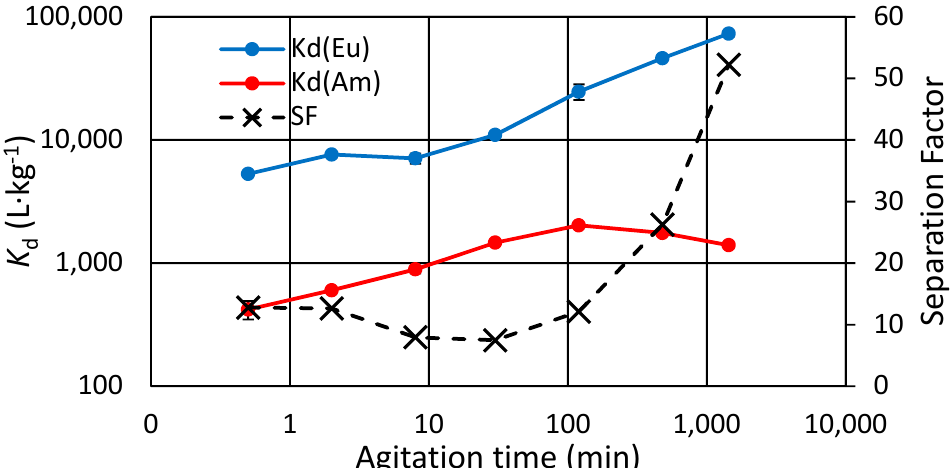
Figure 2. Distribution coefficients for ZrP for Eu(III) and Am(III) in a binary solution, nitric acid (pH 1.5) with 0.1 mol ∙ L − 1 NaNO 3 as a function of equilibrating time. Separation factor (SF) is calculated as K d (Eu): K d (Am).